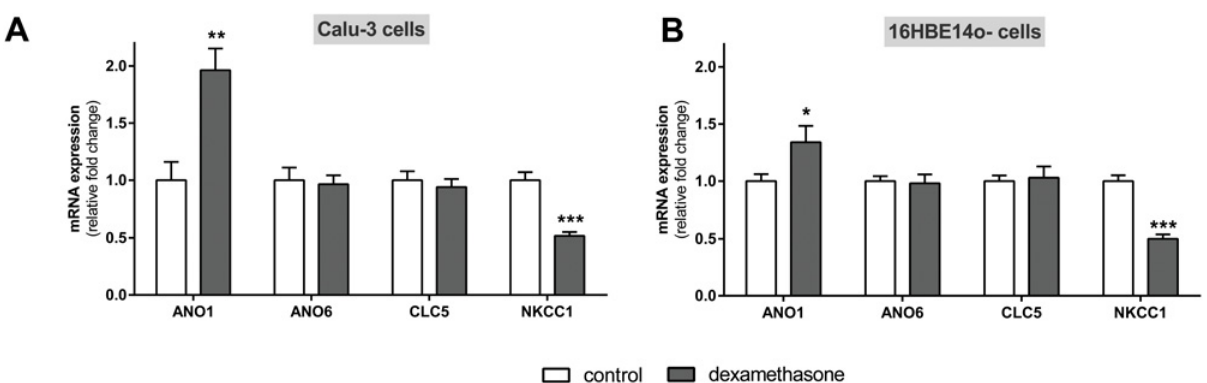
Fig 10. Dexamethasone modulates alternative chloride transporters in bronchial cells. Graphs represent the mean + SEM for normalized mRNA expression in response to 100 nM dexamethasone for 24 h acquired by RT-qPCR. A: Calu-3 cells (n = 8 – 14, ** p < 0.01, *** p < 0.001, T-test compared to control cells without dexamethasone addition). B: 16HBE14o- cells (n = 7 – 8, * p < 0.05, *** p < 0.001, T-test compared to control cells without dexamethasone addition).